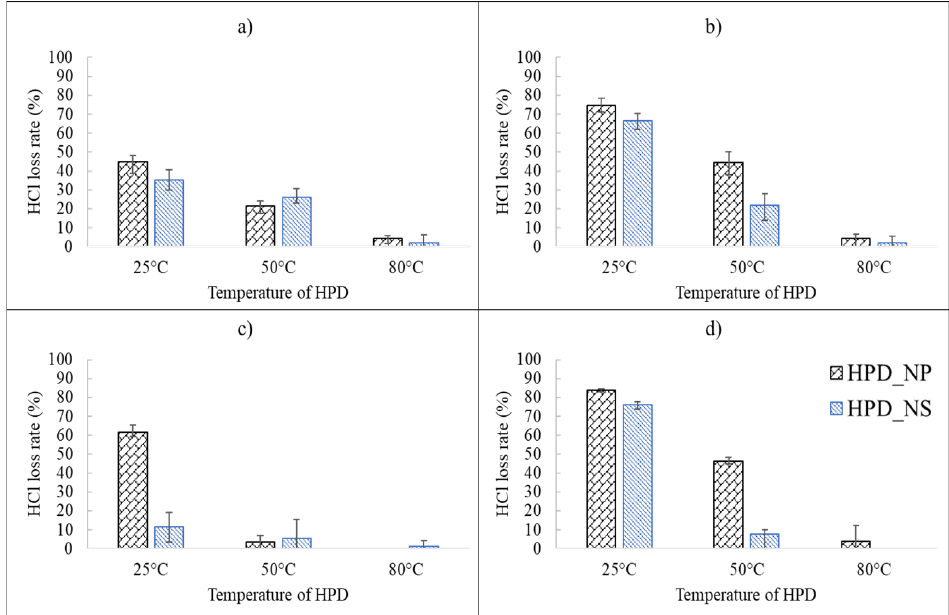
Figure 6. HCl loss rates of HPD_NP and HPD_NS with respect to various temperatures and other conditions: ( a ) low humidity (4%) and 5 ppmv HCl, ( b ) high humidity (17%) and 5 ppmv HCl, ( c ) low humidity (4%) and 10 ppmv HCl, and ( d ) high humidity (4%) and 10 ppmv HCl.